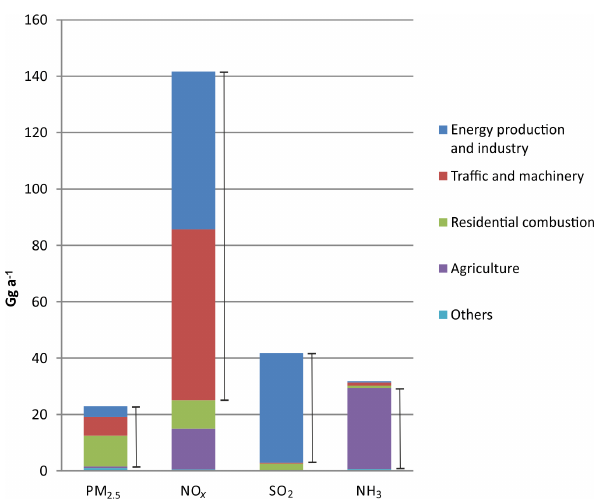
Figure 1. The total amounts of the annual emissions in Finland in 2015 for the pollutants and source categories that were taken into account in this study (Mtyr − 1 ). The NO x emissions were defined as the sum of NO and NO 2 and presented as the mass of NO 2 . The vertical bars show the emission source categories that were included in the simplified web-based assessment